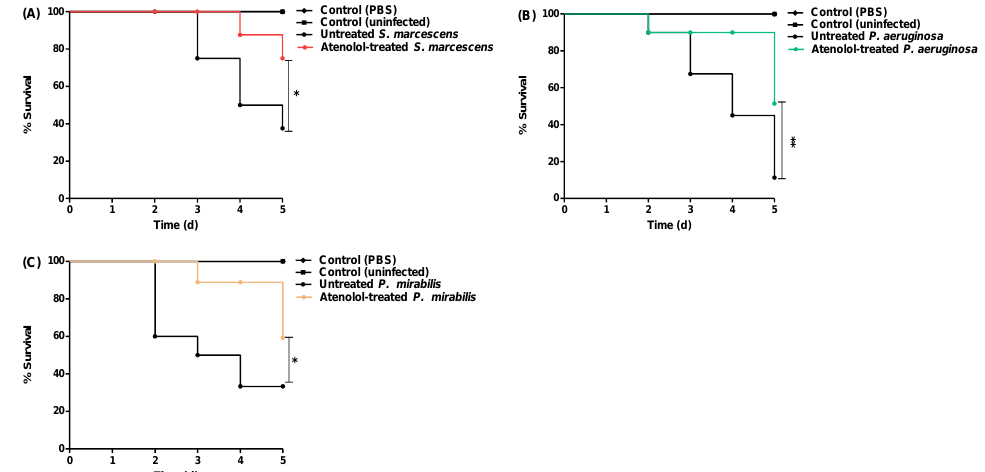
Figure 13. Atenolol protected mice from ( A ) S. marcescens , ( B ) P. aeruginosa , and ( C ) P. mirabilis . Atenolol at sub-MIC showed a significant capacity to protect mice from S. marcescens , P. aeruginosa , and P. mirabilis pathogenesis (log rank test for trend p = 0.0289, 0.0025, and 0.0111, respectively). (* p < 0.05, ** p < 0.01).